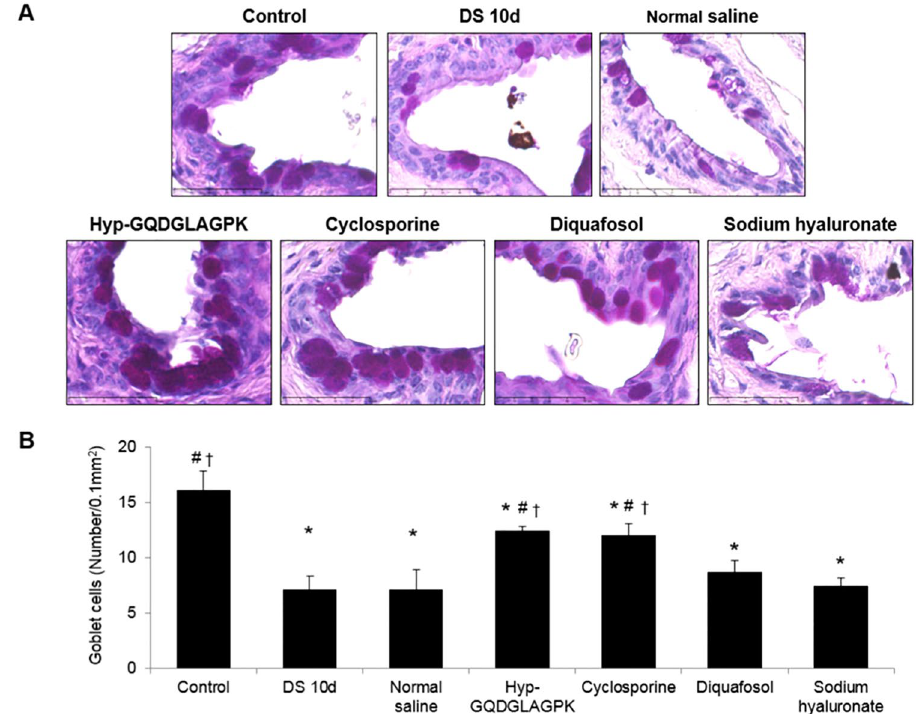
Figure 5. Effect of Hyp-GQDGLAGPK on conjunctival goblet cell densities in the experimental dry eye mouse model. ( A ) The goblet cells of the conjunctiva were stained with PAS before desiccation stress, immediately after desiccation stress for 10 days, and 10 days after treatment with Hyp-GQDGLAGPK, cyclosporine, diquafosol, and sodium hyaluronate eye drops. Scale bar = 50 μ m. ( B ) The goblet cell densities of each group are presented as means ± SD (n = 4~5 eyes). The results are statistically significant by analysis of variance with the Tukey test at * p < 0.05 compared with baseline, # p < 0.05 compared with DS 10d and † p < 0.05 vs corresponding value in the normal saline